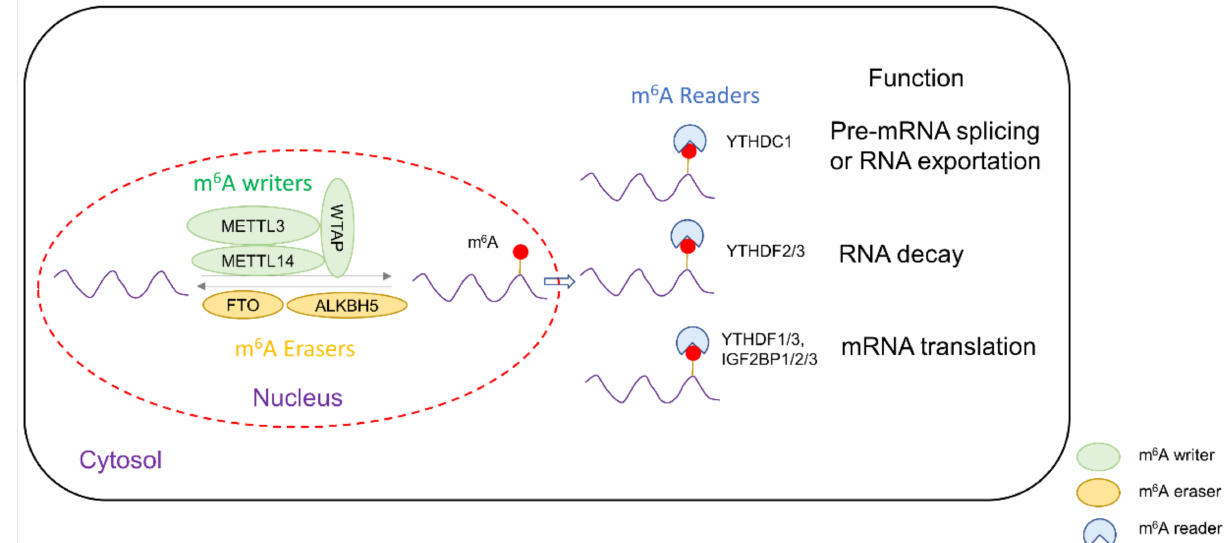
Figure 1. Schematic diagram showing the roles of m 6 A writer, easers and readers in the post- transcriptional regulation of